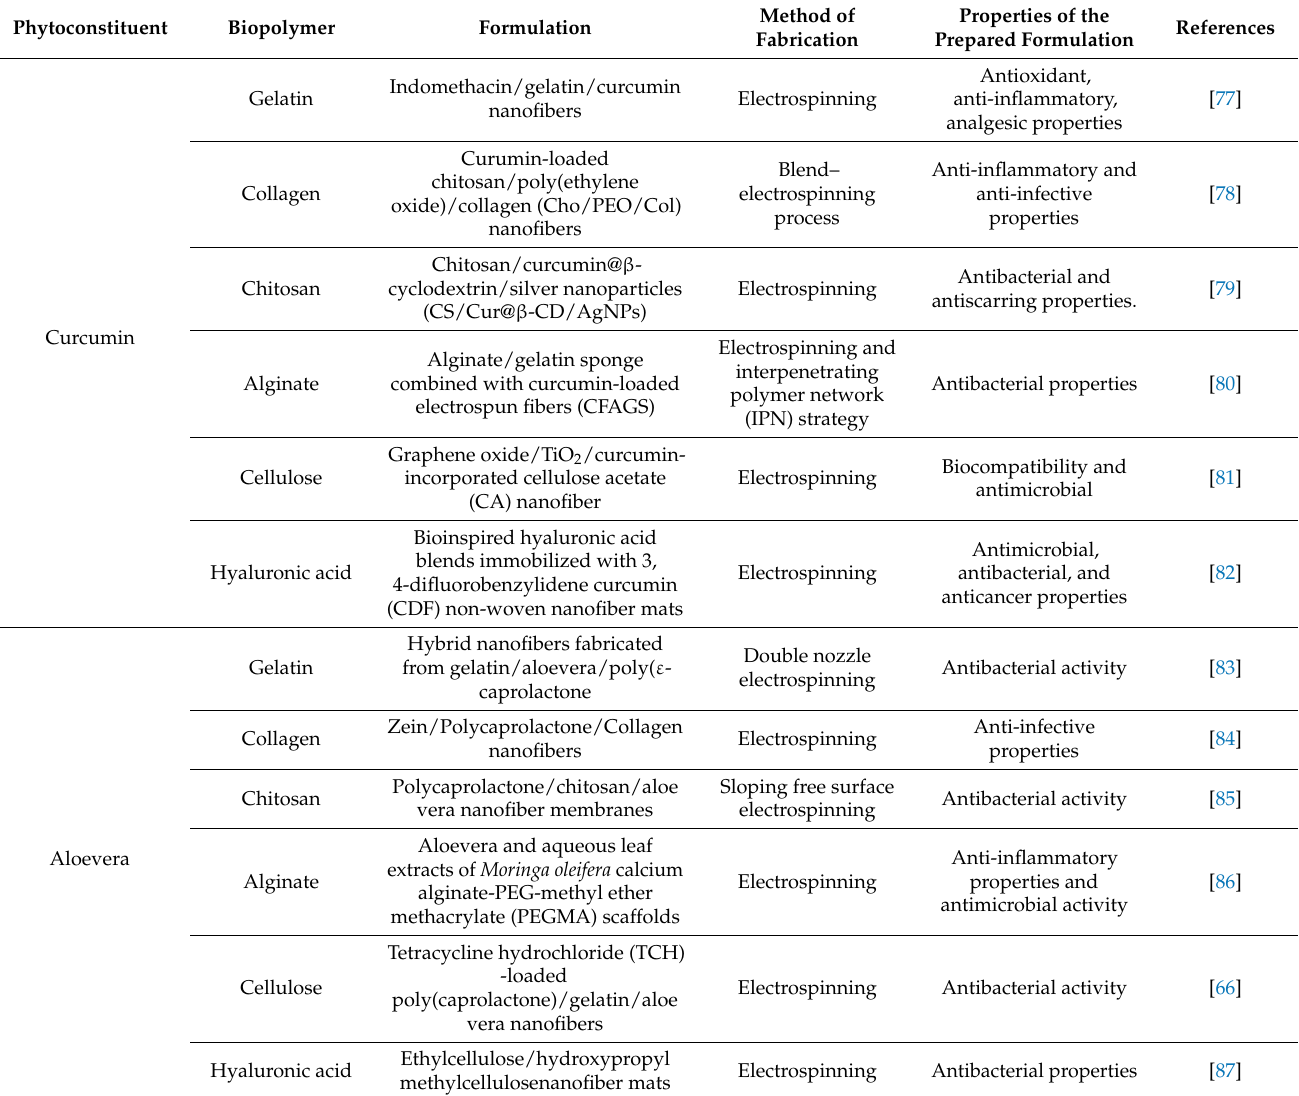
Table 1. Various herbal bioactive-loaded nanofibrous meshes with their